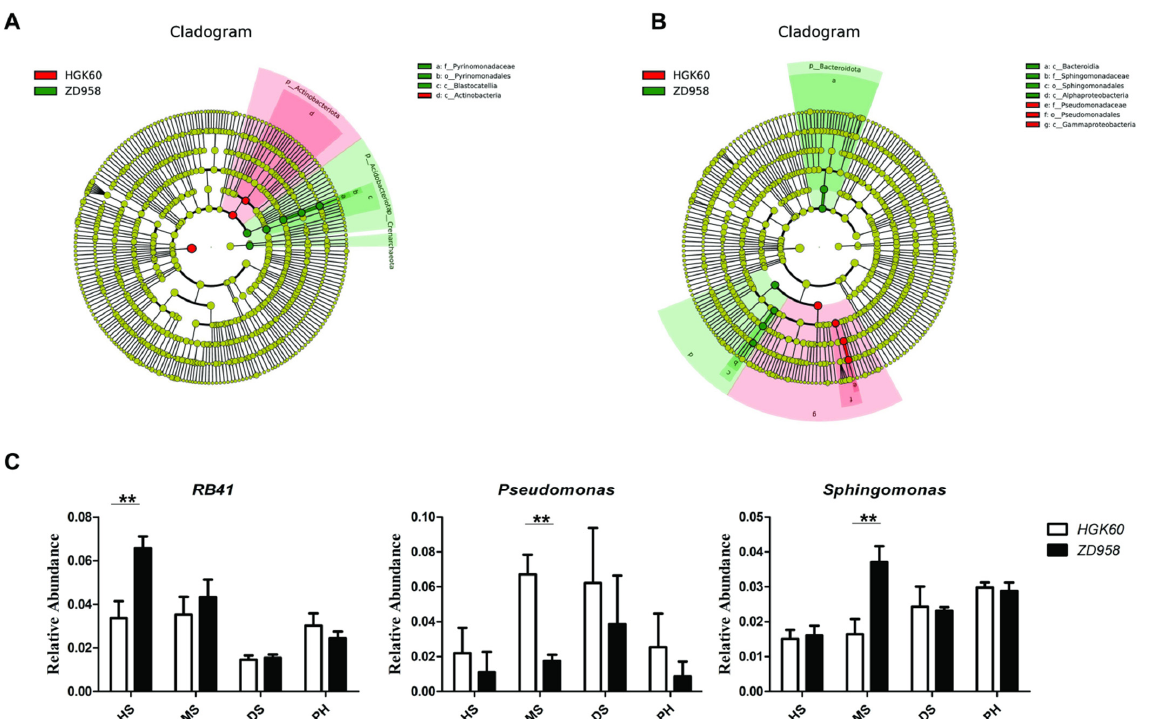
Figure 3. The identification of bacterial biomarkers resulting in the difference in composition of rhi- zosphere bacteria between HGK60 and ZD958 at early stages. ( A , B ) The bacterial biomarkers of HGK60 and ZD958 at the heading stage and milk stage; ( C ) the relative abundance of bacterial bi-